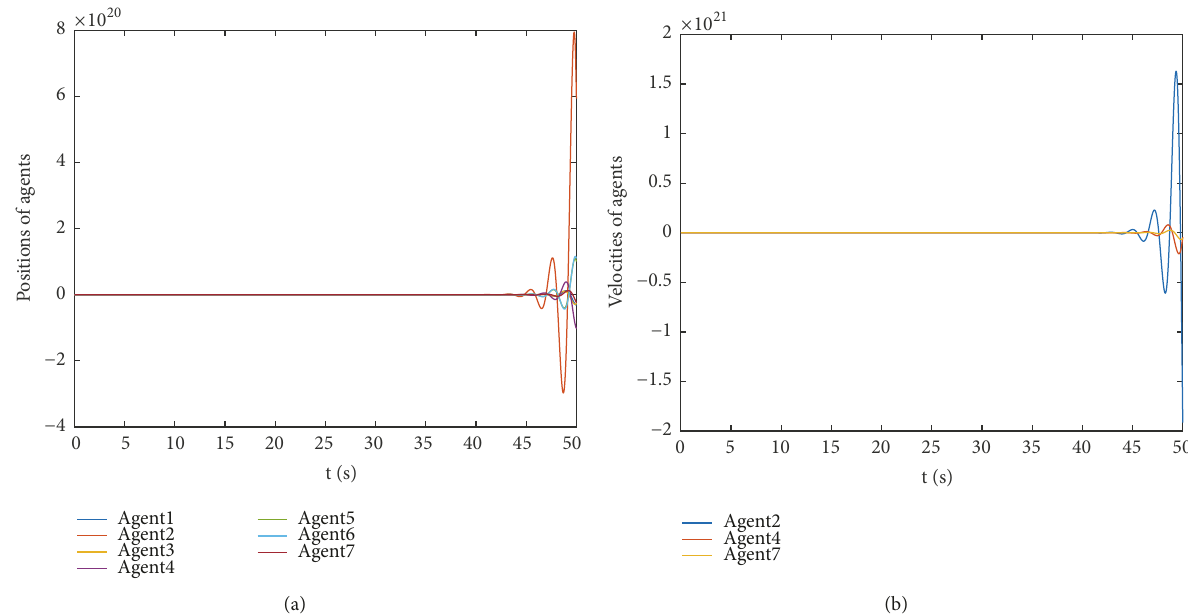
Figure 5: The statetrajectories of the agents under undirectedtopology in Figure 1 with different input time delays 𝜏 1 = 0.2 , 𝜏 2 = 0.5 , 𝜏 3 = 0.1 , 𝜏 = 0.1 , 𝜏 = 0.15 , 𝜏 = 0.25 , 𝜏 = 0.2 , communication delay 𝜏 4 5 6 7